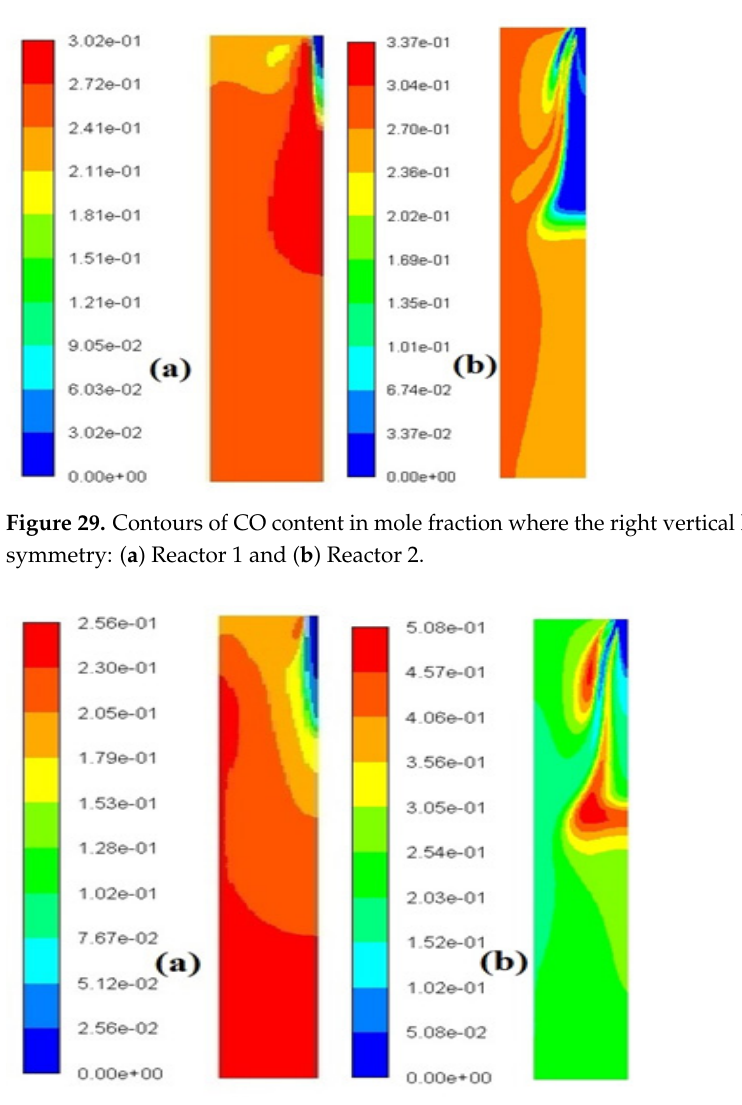
Figure 28. Contours of H 2 content in mole fraction where the right vertical line represents the axis of symmetry: ( a ) Reactor 1 and ( b ) Reactor 2.